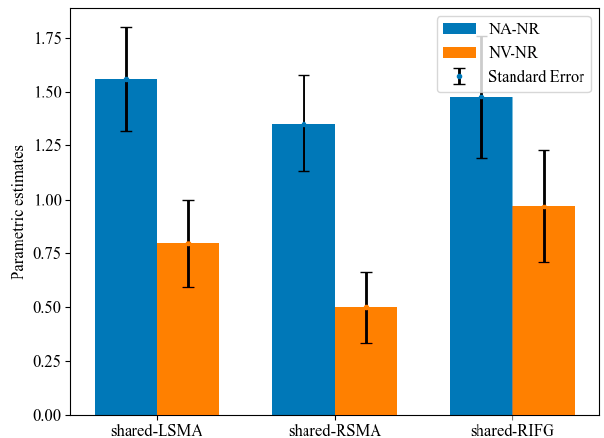
Figure 6. Parametric estimates for NA-NR and NV-NR in shared regions. The mean parameters of NA-NR were significantly higher than those of NV-NR in the shared-LSMA and shared-RSMA.